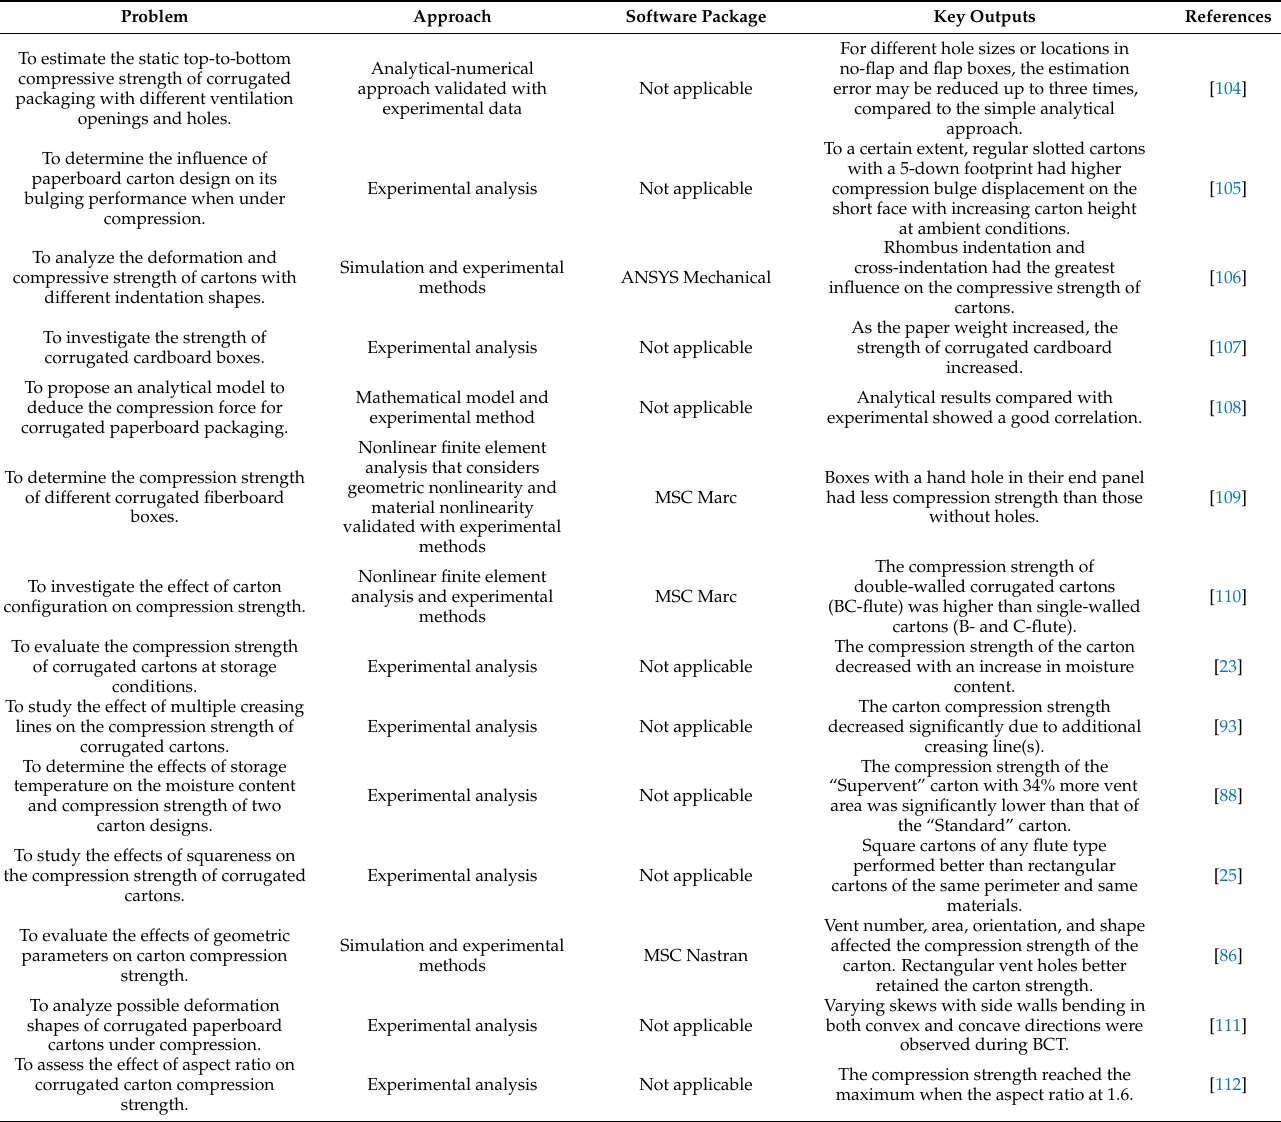
Table 5. Examples of different studies on compression strength of